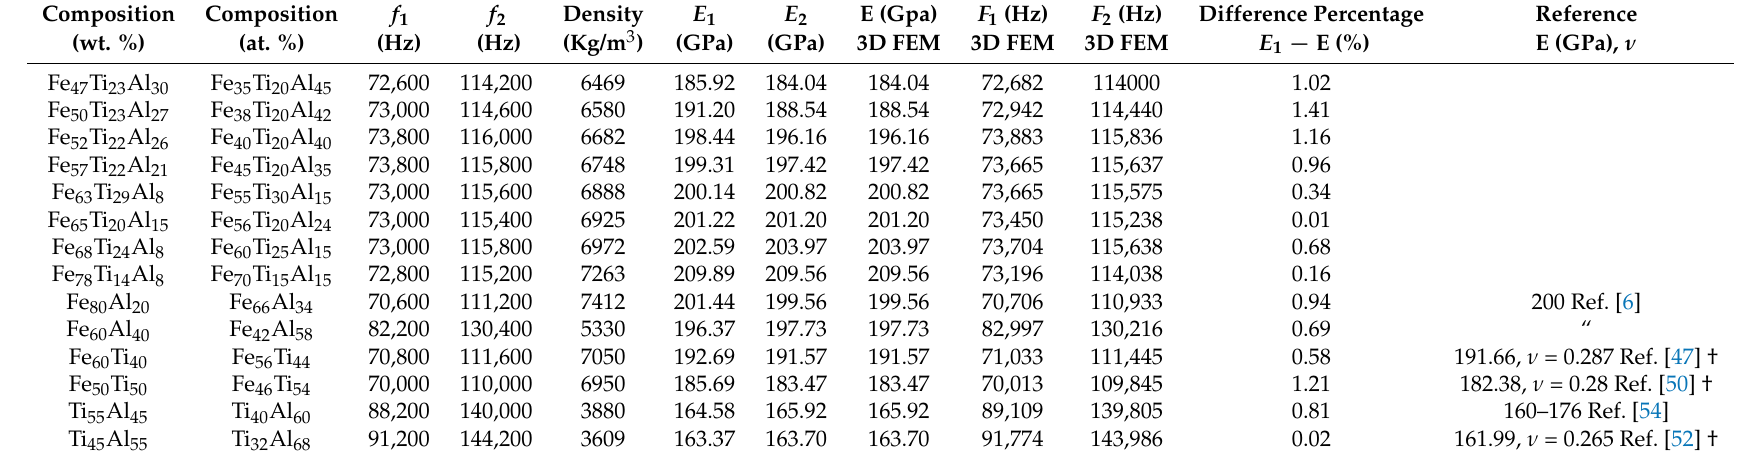
Table 3. The resonance frequencies ( f 1 , f 2 ) recovered from the vibration spectra obtained using piezoelectric disc transducers and the corresponding Young’s moduli ( E 1 , E 2 ) retrieved using Equation (2). The final 3D FEM Young’s moduli ( E ) after adjustment to fit experimental resonance frequencies. The difference between E 2 and E is given in percentage. The † indicates ab initio calculated results found in the literature. The values of K 1 = 4.6356, K 2 = 7.3284, and the initial ν =